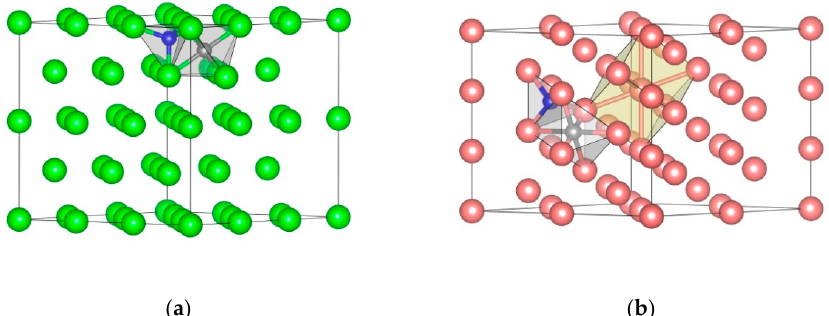
Figure 1. The interstitial sites in the ( a ) zirconium and ( b ) niobium supercells. Tetrahedral sites are blue, and octahedral sites are grey.